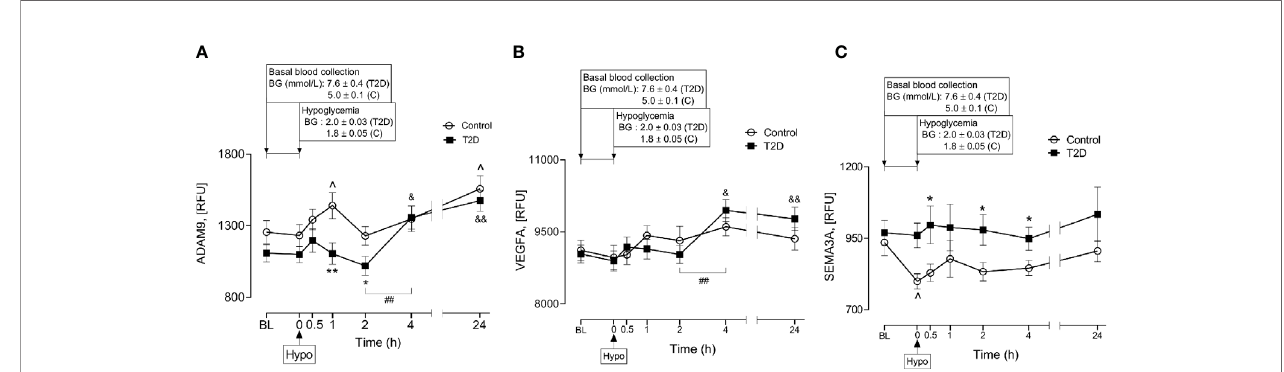
FIGURE 4 | Plasma levels of A Disintegrin and Metalloproteinase 9 (ADAM9), class 3 semaphorins (SEMA3A) and vascular endothelial growth factor (VEGF) before, during and after iatrogenic induction of hypoglycemia. Changes in plasma ADAM9 (A) , VEGF (B) and SEMA3A (C) levels in response to hypoglycaemia and post- hypoglycemic timepoints in control (white circles) and T2D (black squares) subjects. *p < 0.05, **p < 0.01, control vs T2D; ^p < 0.05, control hypoglycaemia vs control post-hypoglycemia timepoints; & p < 0.05, && p < 0.01, T2D hypoglycaemia vs T2D post-hypoglycemia timepoints; ## p < 0.01, T2D 2-h post-hypoglycemia vs T2D 4-h post-hypoglycemia. Hypo, hypoglycemia; RFU, relative fl